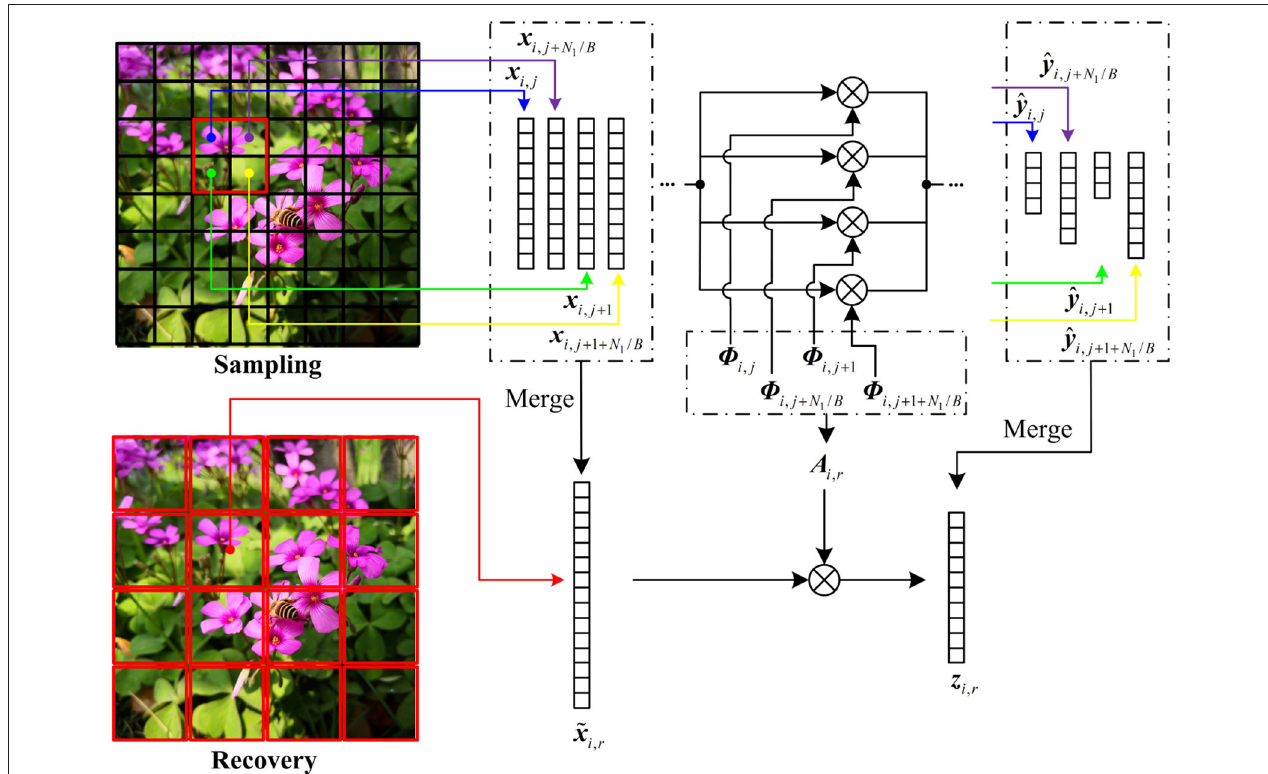
FIGURE 6 | Illustration on block merging when lev is set to be